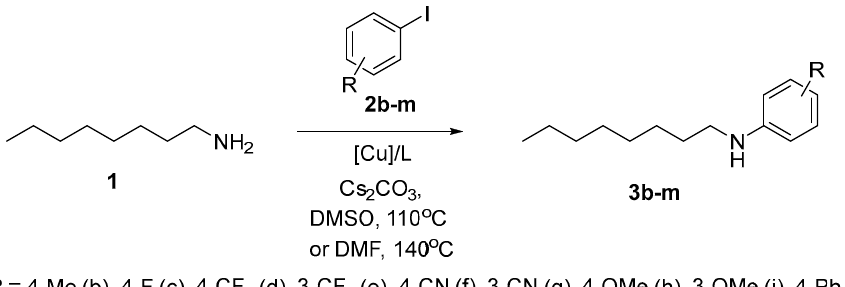
Table 2. Arylation of n -octylamine ( 1 ) with iodobenzene ( 2a ) in the presence of Cu 2 O and CuO 1 . Entry Copper